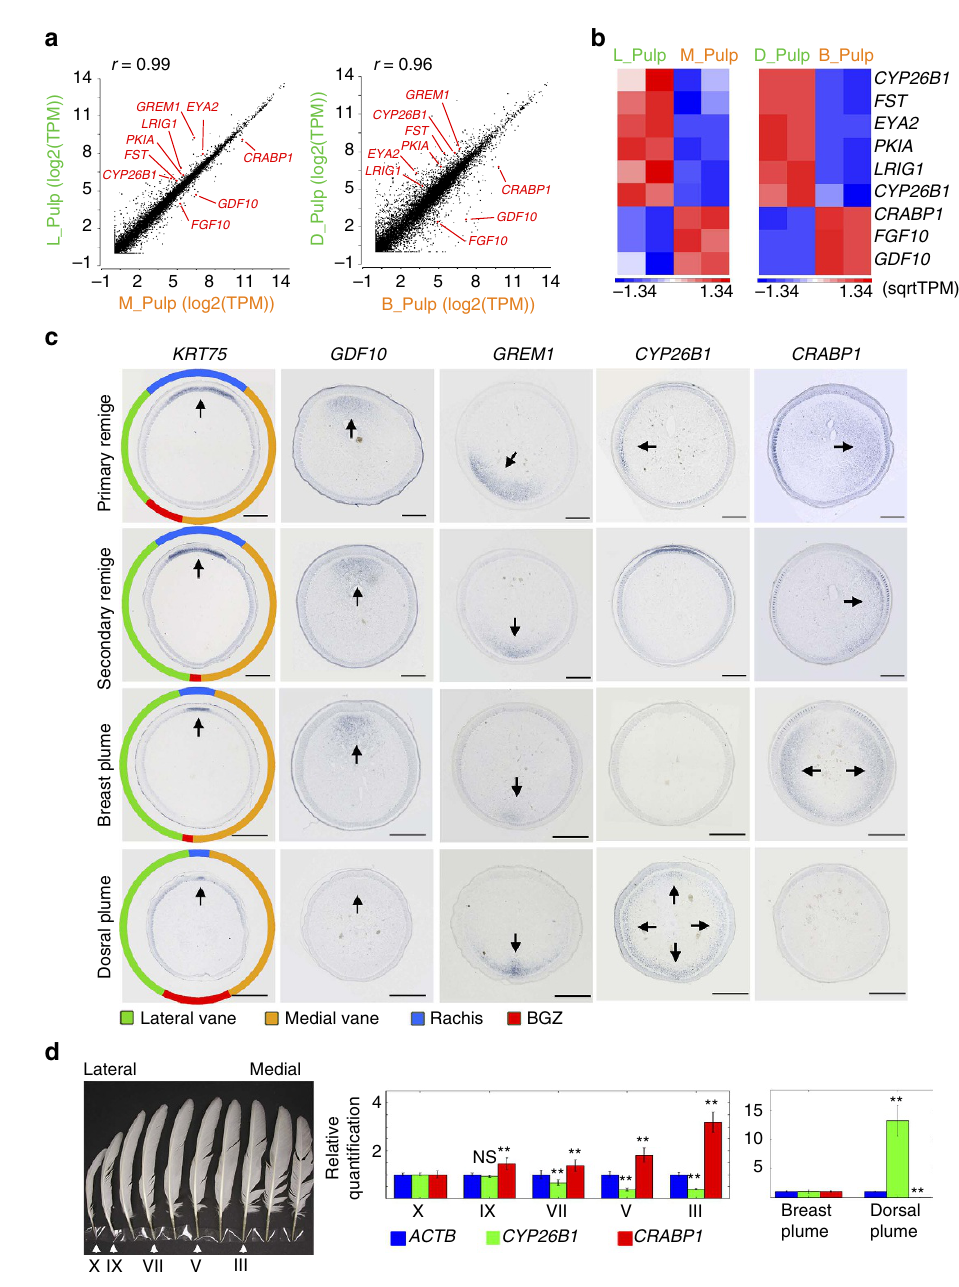
Figure 2 | Identifying key molecular regulators of feather vane shapes. ( a ) Scatter plots depicting the transcriptomic comparisons between lateral and medial primary remige pulp, dorsal and breast plume pulp, respectively. Among the differentially expressed genes we picked out crucial signalling molecules (red) for further characterization. The linear correlation coefficient ( r ) is very close to 1, indicating highly similar transcriptome profile between samples. ( b ) The highlighted genes are clustered in two groups, one associated with narrower vanes and the other associated with wider vanes (L and M are the lateral side and medial side of primary remige; D, dorsal plume; B, breast plume, respectively. Two biological replicates are shown). ( c ) Candidate genes highlighted by RNA-seq analysis demonstrated differential localization in the pulp of growing feathers with different vane shapes (arrows). KRT75 is highly expressed in the rachis epithelium and hence was used as a marker for position alignment between samples. Scale bars, 500 m m. ( d ) qPCR for CYP26B1 and CRABP1 in the pulp of primary remiges along the wing (lateral-to-medial: X, IX, VII, V, III, n ¼ 3 for each position) demonstrates gradually decreased CYP26B1 expression and increased CRABP1 expression. While dorsal plumes have more strikingly elevated CYP26B1 and downregulated CRABP1 expression compared with the breast plumes ( n ¼ 3). Error bars denote s.d. (cid:2)(cid:2) P o 0.01, NS, not (1.93-fold) (Fig. 2a,b, Supplementary Tables 1 and 2). In situ (Supplementary Fig. 6). Nuclear CRABP1 implies its potential hybridization also demonstrated complementary expression role in trans-activating nuclear RA receptors 27 . Therefore, patterns of CYP26B1 and CRABP1 (Fig. 2c). CRABP1 CRABP1 protein likely promotes RA signalling in the pulp RA signalling gradient in primary remiges.